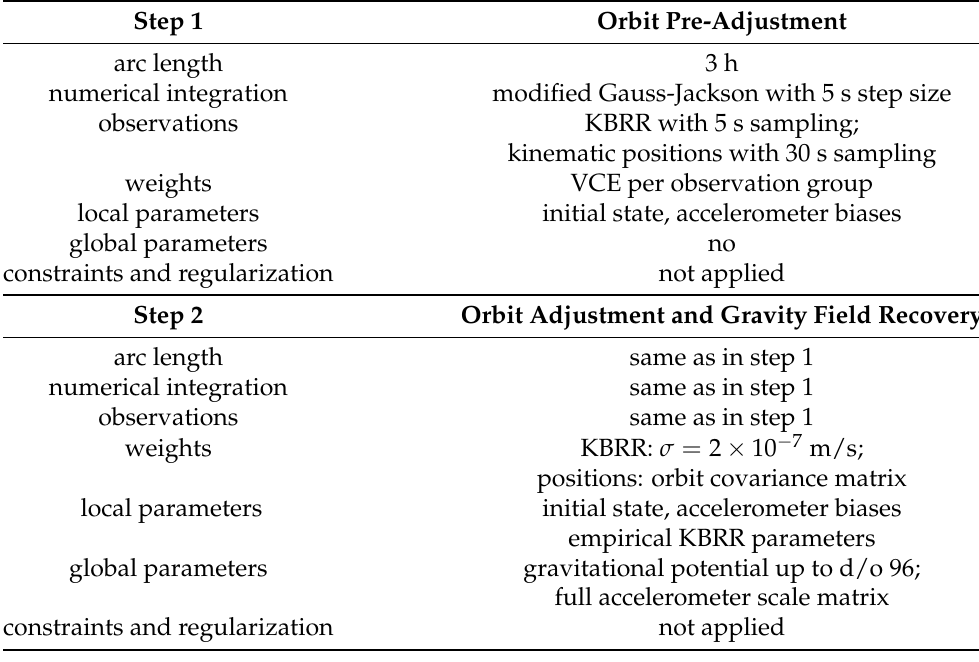
Table 2. Main specifics of the gravity field recovery two step approach. VCE: Variance Component Estimation; σ : standard deviation; d/o: